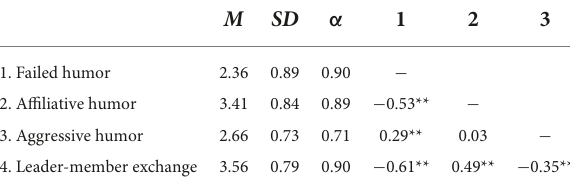
TABLE 3 Descriptive statistics and intercorrelations between study